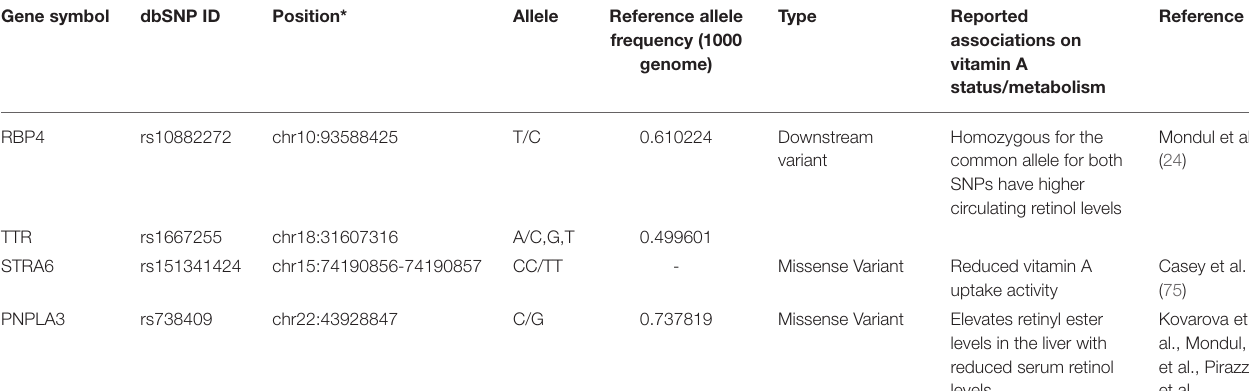
TABLE 3 | A list of sequence polymorphisms and the reported associations on transport, absorption, and storage of vitamin A in